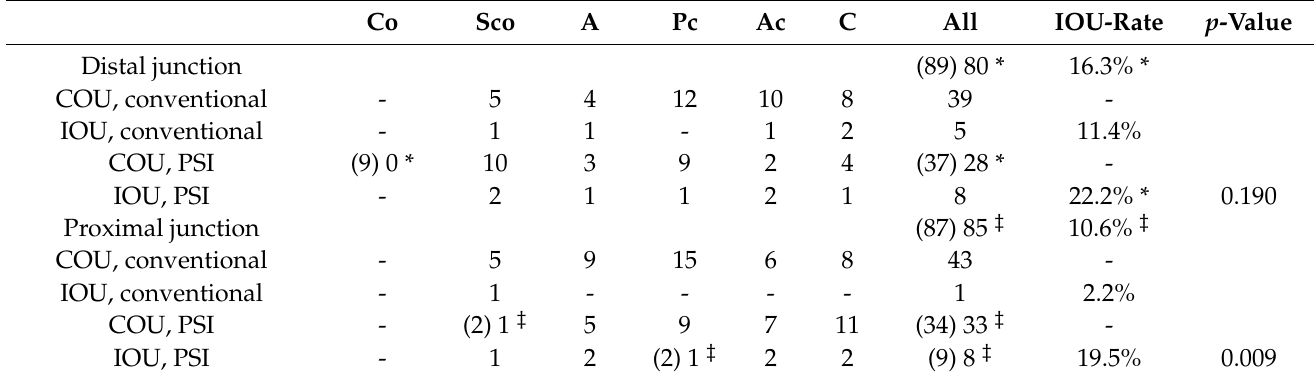
Table 3. Overall incomplete (IOU) versus complete osseous union (COU) was categorized concerning the used plate system and according to the distal or proximal end of the FFF. Co: Condyle; Sco: subcondyle; A: angle; Pc: posterior corpus mandibulae; Ac: anterior corpus mandibulae; C: canine;